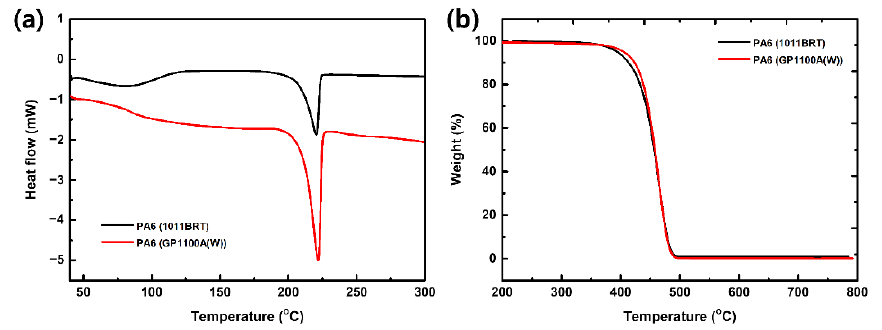
Figure 3. Analyses of PA6 resins: ( a ) DSC and ( b ) TGA.